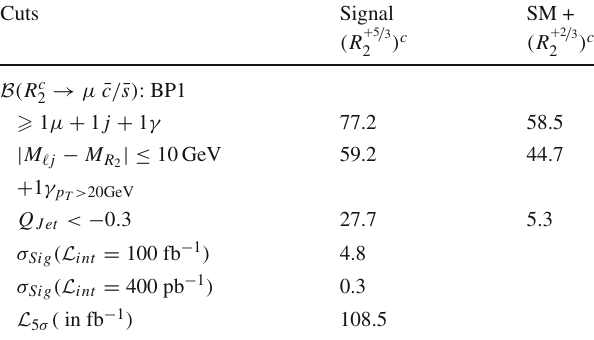
Table 6 Number of signal and background events after the cumulative cuts for the scalar doublet leptoquark R c well as integrated luminosity required for 5 σ significance at HERA are